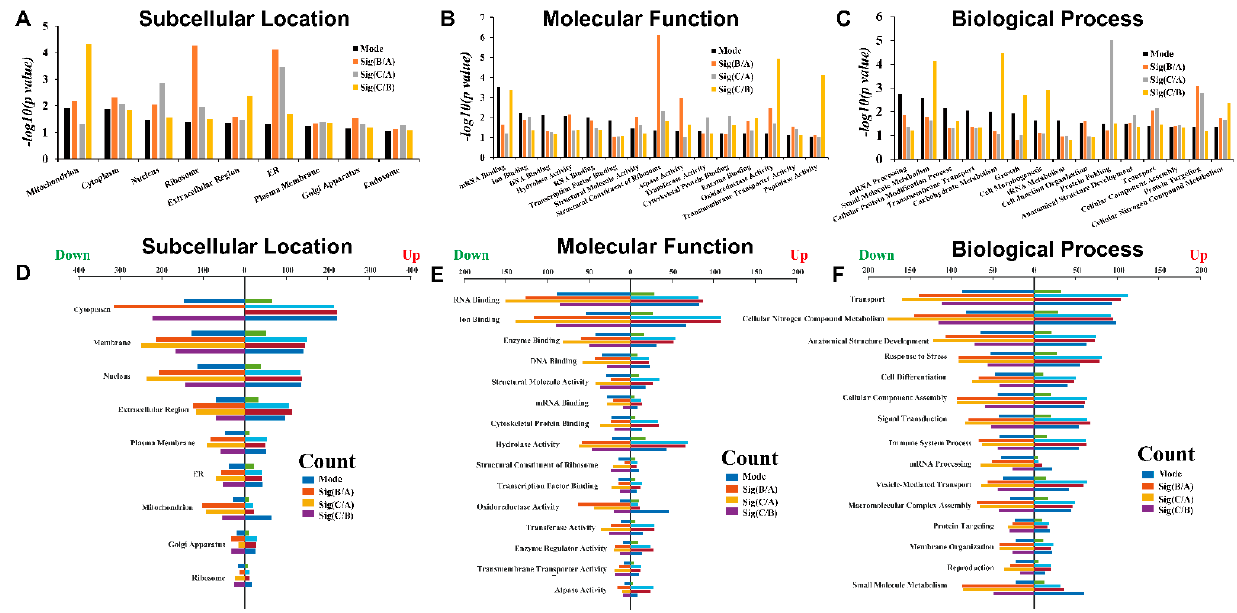
Figure 4. Go analysis of differentially expressed proteins. Figures (A–C) show the p value distributions of subcellular localization, molecular function and biological process of GO. Figures (D–F) show the protein counts. Mode-related or pair-wisely differentially expressed proteins (B/A, C/A and C/B) are presented as differently colored bars. The differentially expressed proteins are mostly in the mitochondria. Mode-related differentially expressed proteins are mainly involved in mRNA processing, metabolism, and transmembrane transport. The differentially expressed proteins between B and A are mainly focused in the ribosome and ER. In the subcellular localization and biological process of GO, the differentially expressed protein number of mRNA-related processes are the highest. The proteins that significantly up-regulated and down-regulated proteins belong to different GO categories. The significant differentially expressed proteins between B and A are mainly involved in the transport function. In cytoplasm, the numbers of significantly up-regulated proteins between C and A are much higher than those of down-regulated proteins.